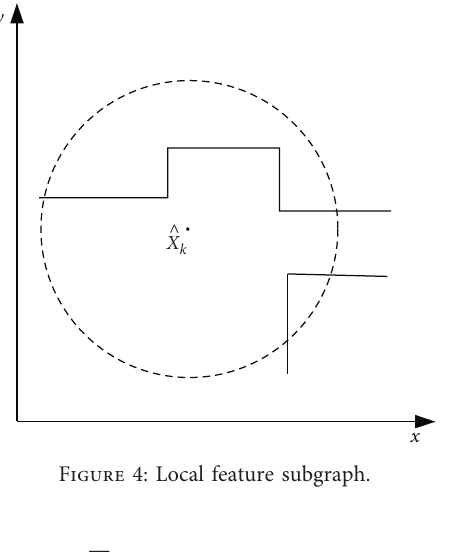
Figure 4: Local feature